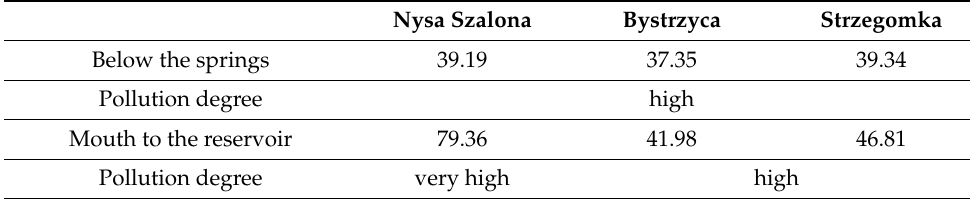
Table 6. Metal pollution index (MPI) of aquatic plants with aluminum—mouth,